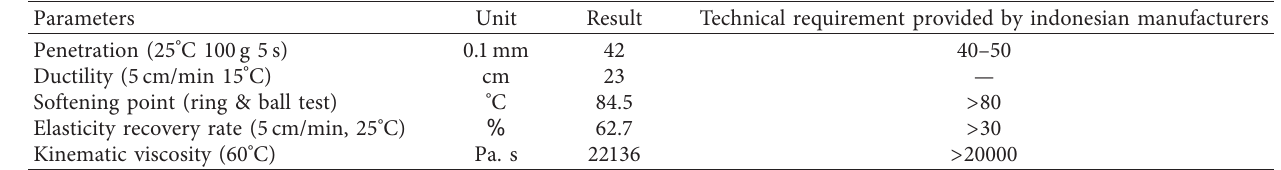
Table 2: Properties of NRA